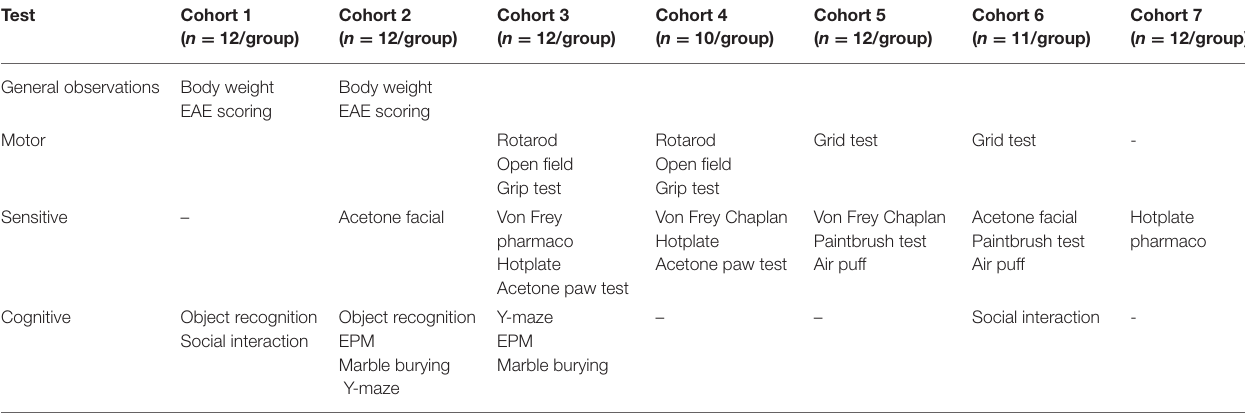
TABLE 1 | Summary table of tests performed by